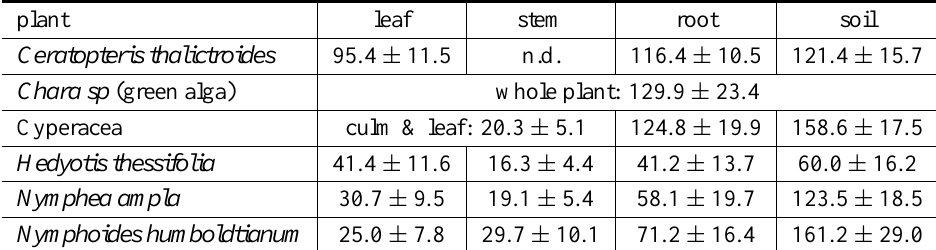
Radioactive concentration (in mBq/g) of polonium-210 in freshwater aquatic plants of the ‘‘Blau-Blau’’ pond, Restinga of Jurubatiba (Carapebus, RJ,